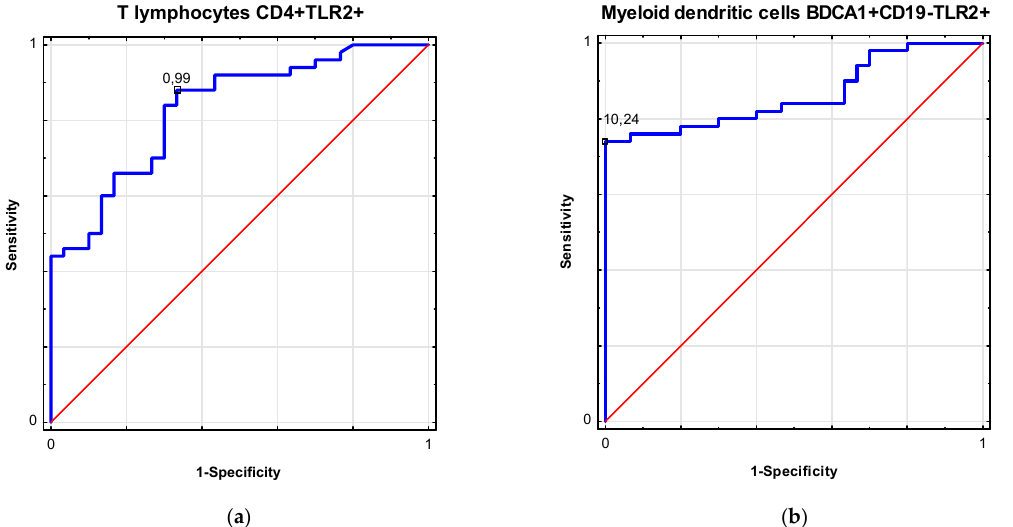
Figure 2. Receiver operating curve (ROC) analysis to determine diagnostic accuracy in differentiation of patients with ovarian cancer: ( a ) frequencies of T lymphocytes CD4+ TLR2+ (%); ( b ) frequencies of myeloid dendritic cells BDCA1+ CD19 − TLR2+ (%).